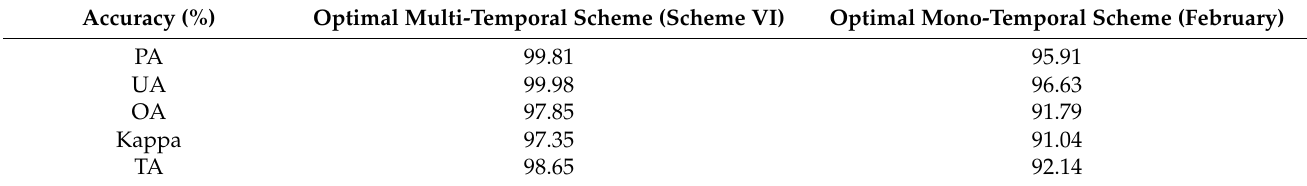
Table 4. Accuracy of optimal multi-temporal and mono-temporal schemes.